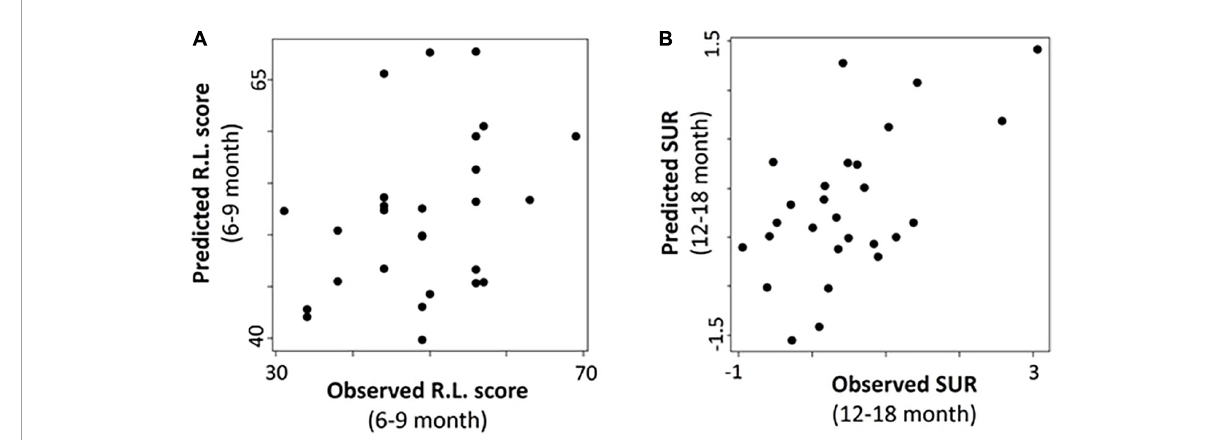
FIGURE7 Association of the predicted and observed receptive language score (R.L.) and surgency (SUR) at the follow-up ages. (A) Predicted vs. observed R.L. at 6–9 months. (B) Predicted vs. observed SUR at 12–18 months.